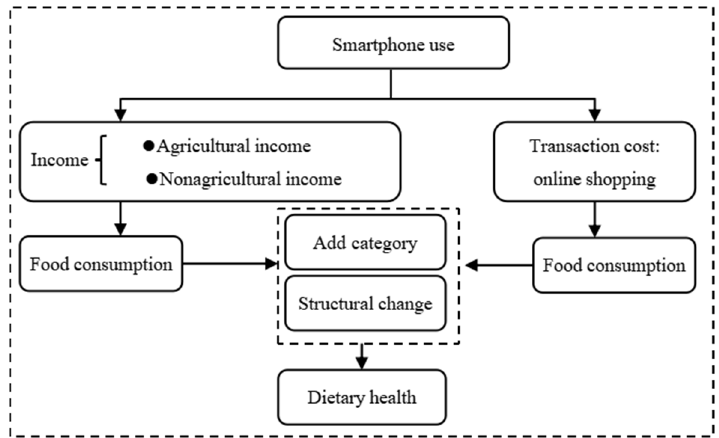
Figure 1. Theoretical Analytical